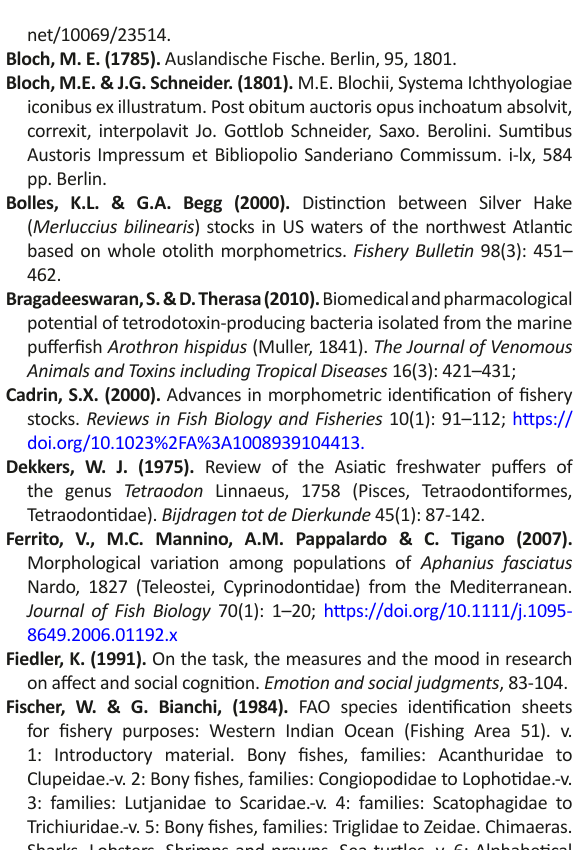
Indian coastal waters are different from one another in morphometric